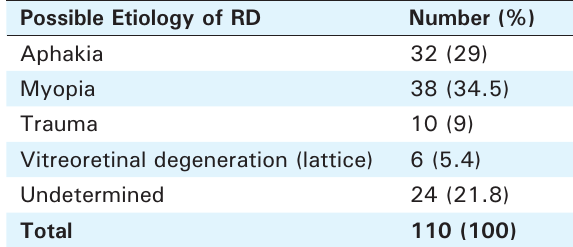
Table 3. Distribution of possible etiology of retinal